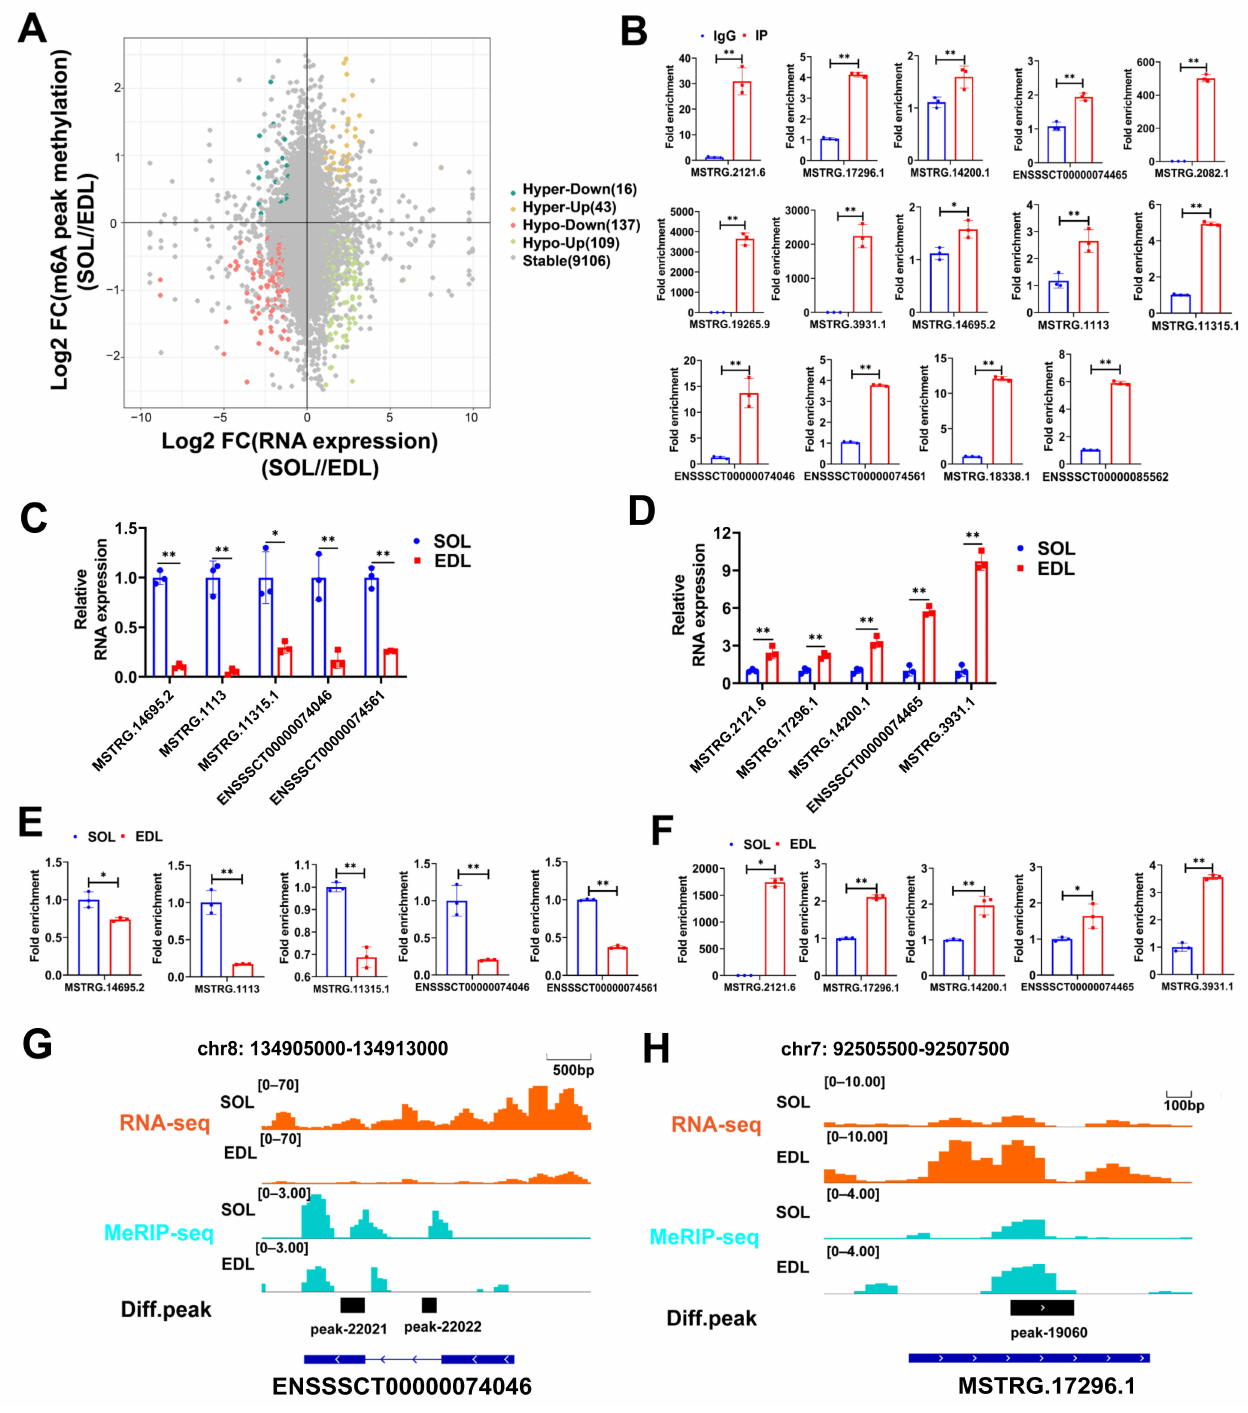
Figure 6. Conjoint Analyses of MeRIP-Seq and RNA-Seq Data. ( A ) Four-quadrant graph showing the distribution of lncRNAs with a marked change in both RNA expressions and m 6 A methylation levels in SOL compared with EDL. Different colors were used to identify representative lncRNAs. ( B ) MeRIP-qPCR validated 14 m 6 A-methylated lncRNAs. IgG was used as negative control. ( C , D ) MeRIP-qPCR